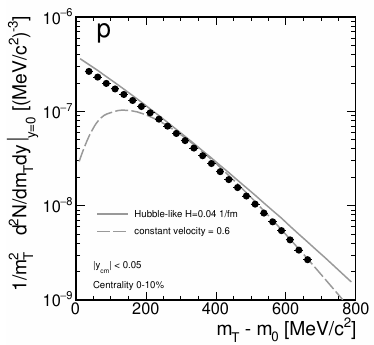
Figure 2. Mid-rapidity transverse mass distribution of protons, measured by HADES [5], compared to thermal model calculations with parameters from [11] and best fits of the fireball radial expansion velocity, assuming either Hubble-like profile β ( r ) = tanh( Hr ) (blue solid curve) or constant velocity (blue dashed curve).